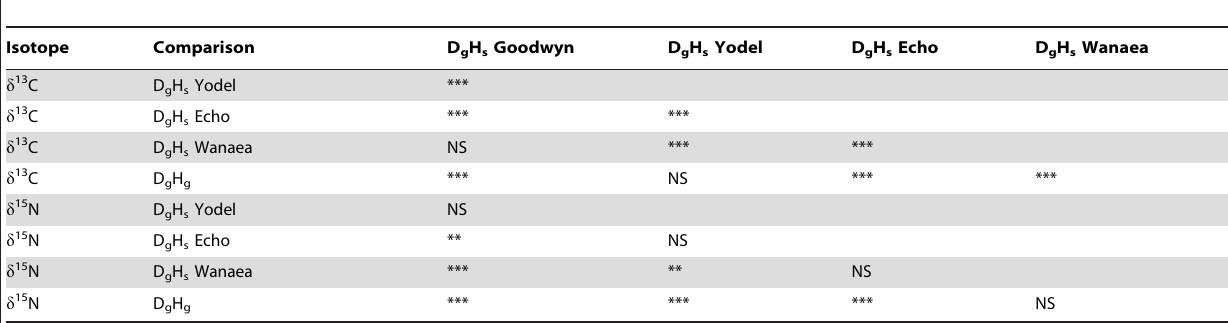
Table 6. Tukey’s post hoc results comparing variances between models using the entire prey assemblage (Part 3).